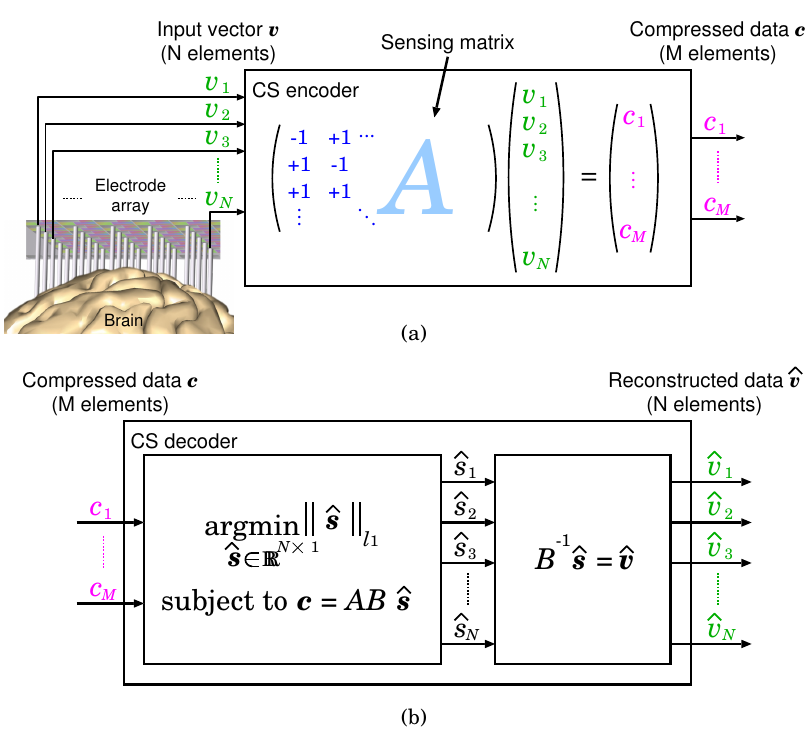
Figure 1. ( a ) Signal measurement (encode) and ( b ) reconstruction (decode) process based on